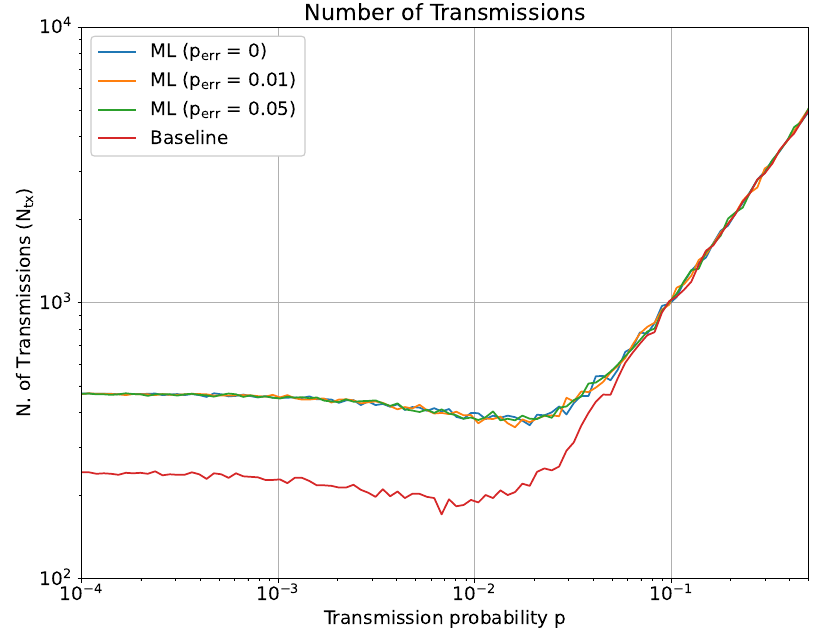
Figure 9. ML-based optimization of the sensor’s AoI: total number of transmissions after 10 4 time slots.